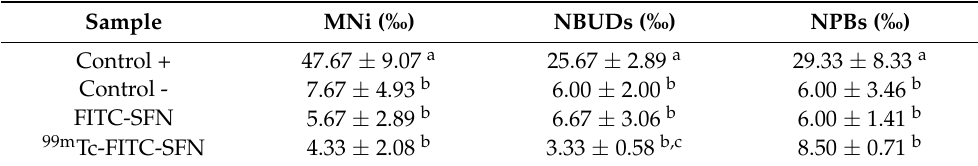
Table 2. Frequencies of micronuclei, nuclear buds, and nucleoplasmic bridges in human lympho- cytes cultured in vitro with radiolabeled nanoparticles by CBMN assay. Sample